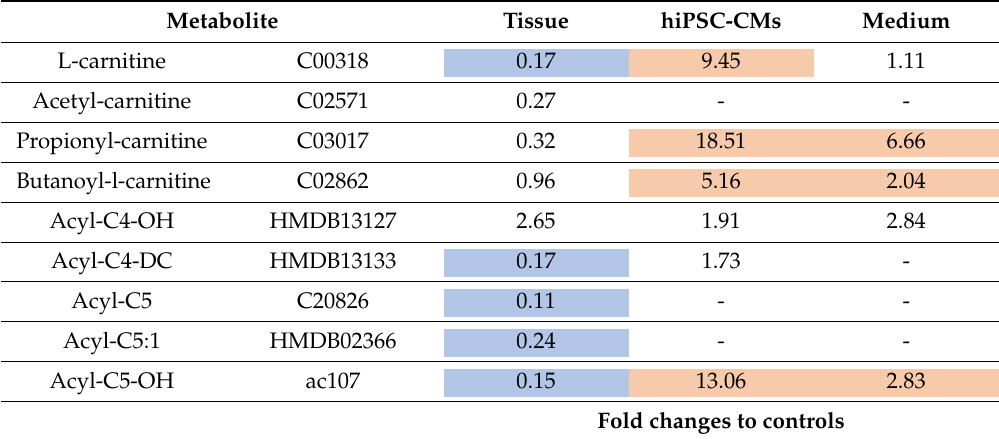
Table 2. Comparison of the metabolome profile of cardiac tissue in comparison to hiPSC-CMs for carnitine and fatty acid metabolism. Accession numbers are indicated according the KEGG [43] or the Human Metabolome Database (HMDB